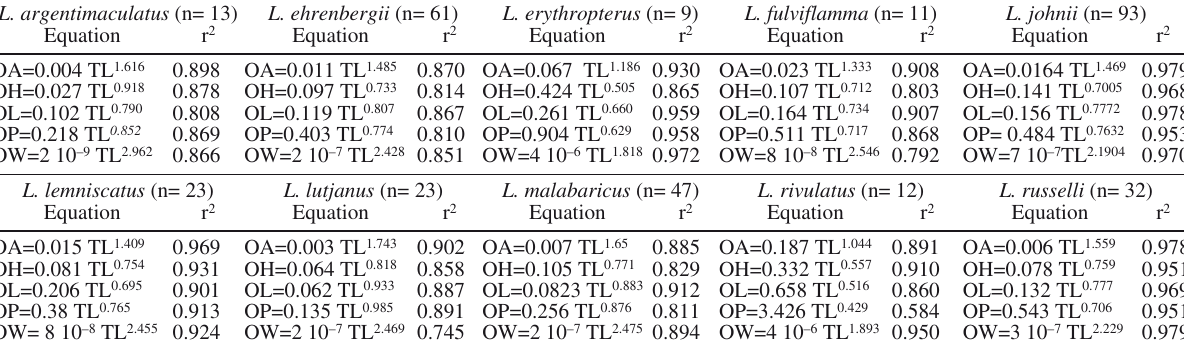
Table 3. − Power relationships between fish length and otolith variables for snappers from the Persian Gulf. OA, otolith area; OH, otolith height; OL, otolith length; OP, otolith perimeter; OW, otolith weight; TL, total length.